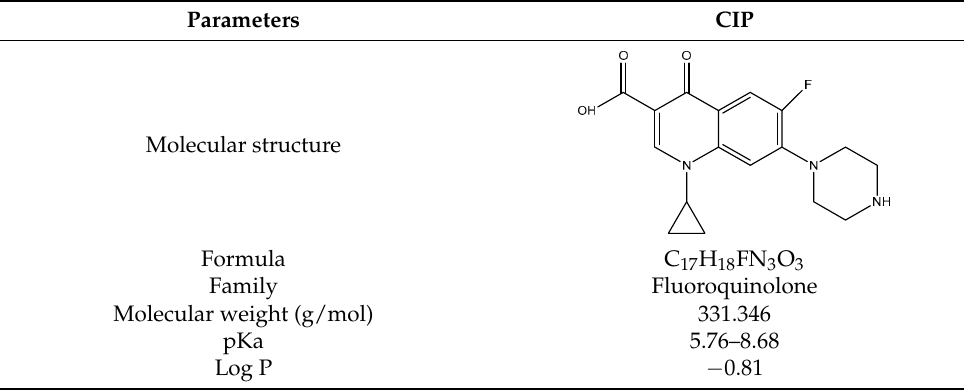
Molecular structure